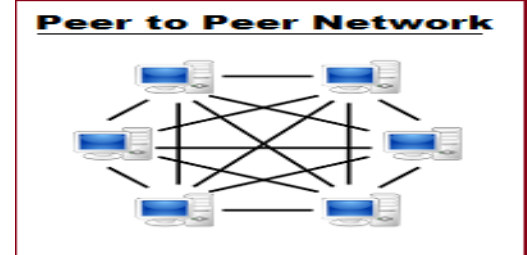
Figure 2: Peer to Peer Network